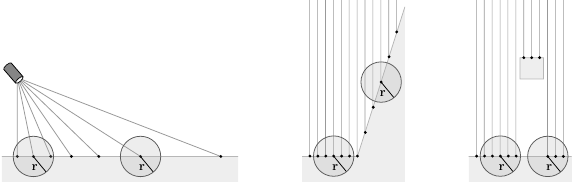
Figure 1: Point density depends on sensor location and orienta- tion (left), and on surfaces geometry (middle). It is also decreased by occluders like trees in front of facades (right). Thus it depends both on acquisition (viewing angle, scanning frequency ...)